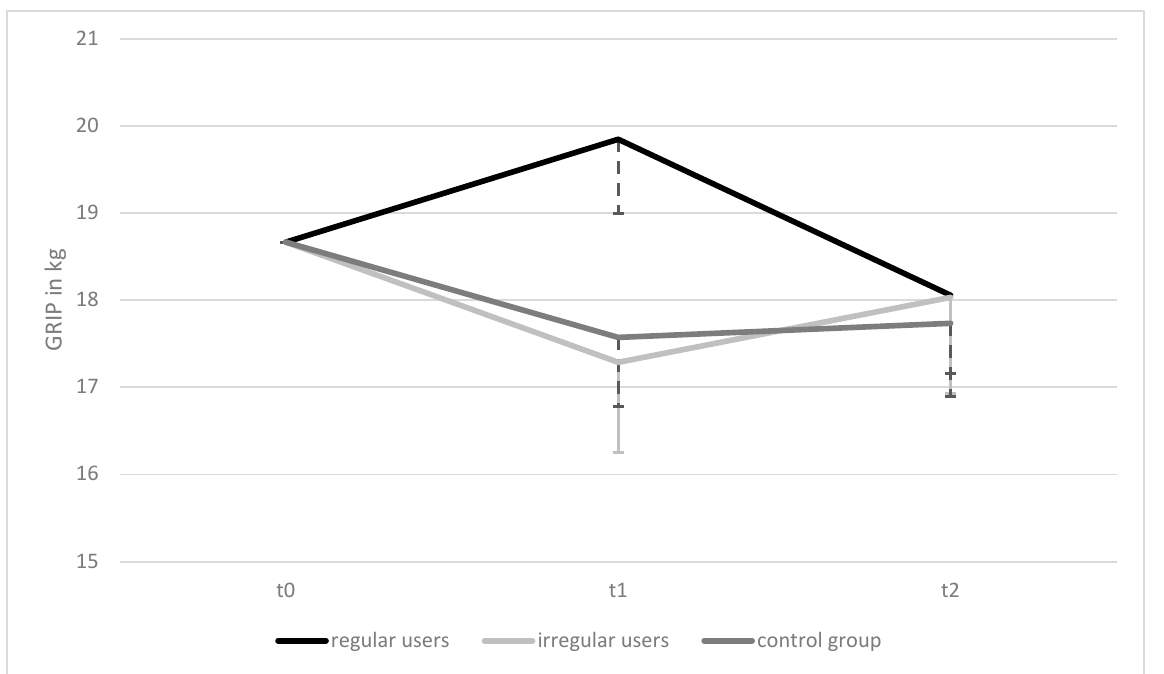
Figure 3. Mean Differences in GRIP ANCOVA Results, Over Time and Between Groups / GRIP = mean grip strength of all attempts from both hands. Data presented as means of all attempts per test date on all three test dates adjusted for baseline values. Error bars (one-sided): 95% CI.